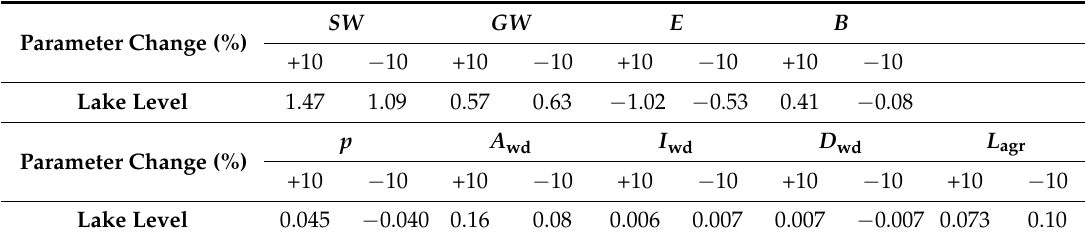
Table 2. Sensitivity analysis of the model